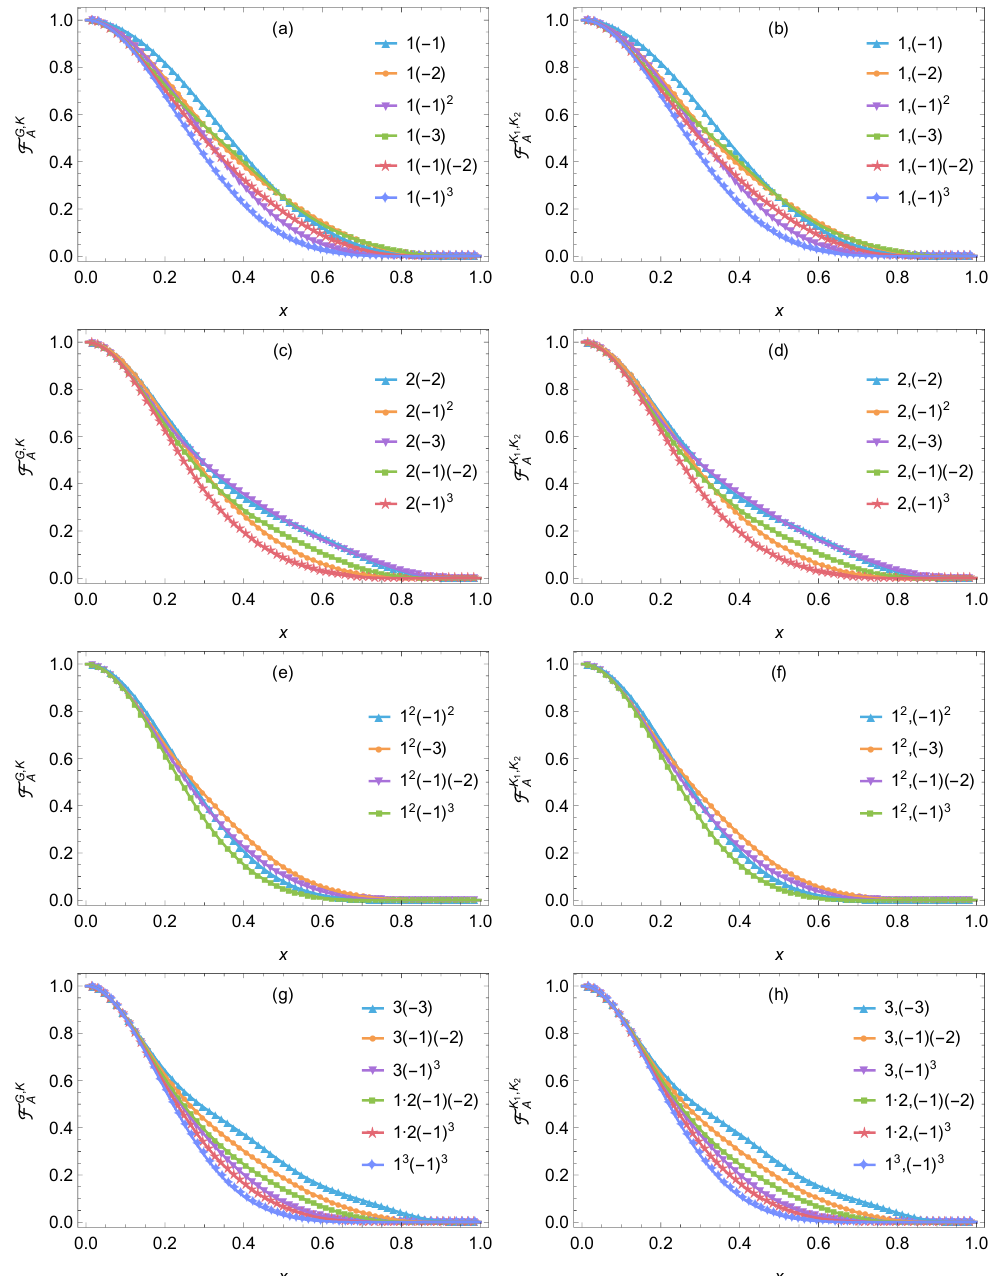
¯ X ¯ X (left column) and F X 1 , (right column) in the 2D free massless 2 2 A A